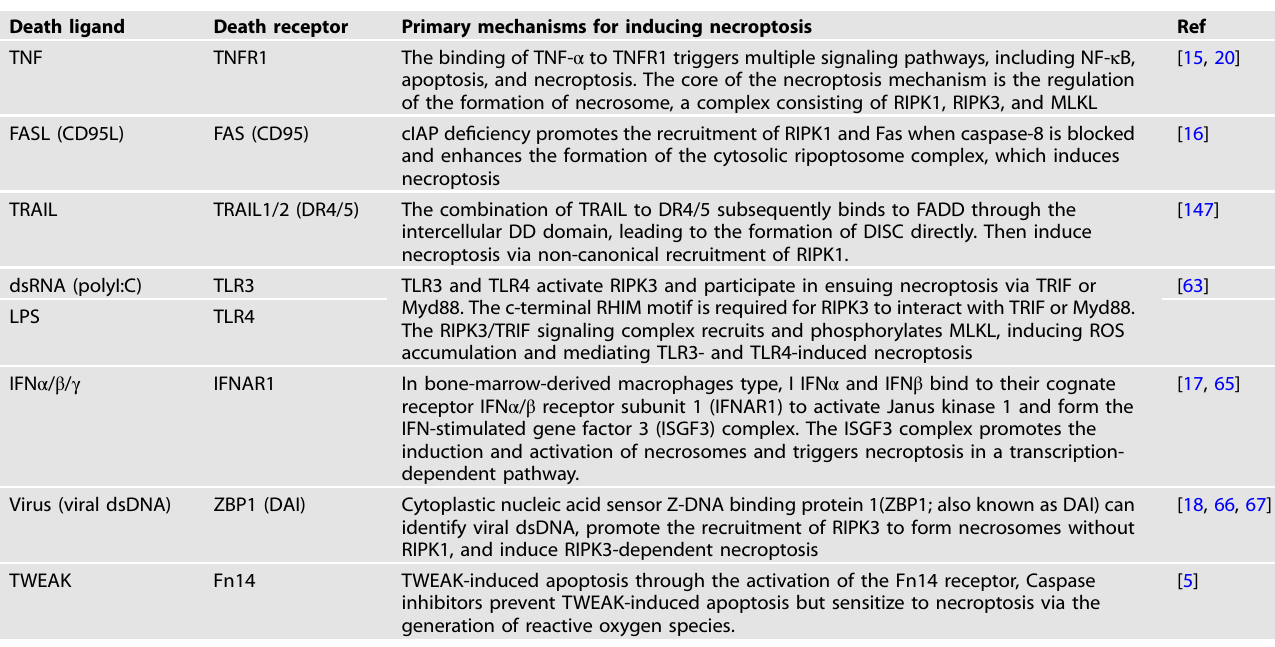
Table 1. The major death receptors that induce